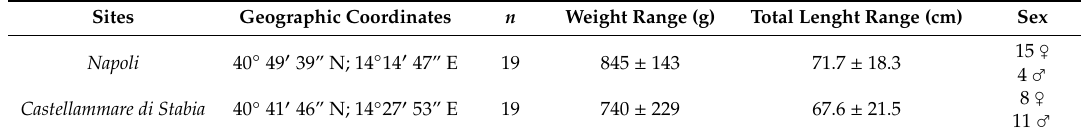
Table 2. Number of individuals (n), weight (g), size (mm) and sex of O. vulgaris captured along the Campania